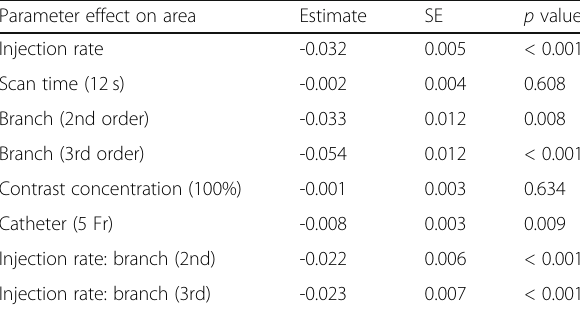
Table 4 Linear mixed model summary for 4D-DSA arterial cross- sectional